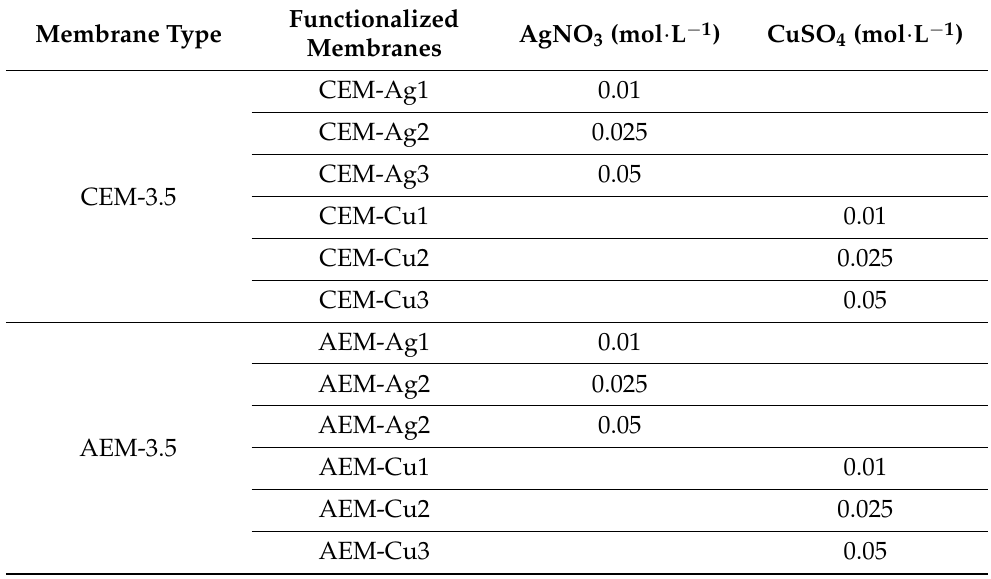
Table 2. Metal precursor concentrations loaded on the custom-made UF heterogeneous IEMs using IMS